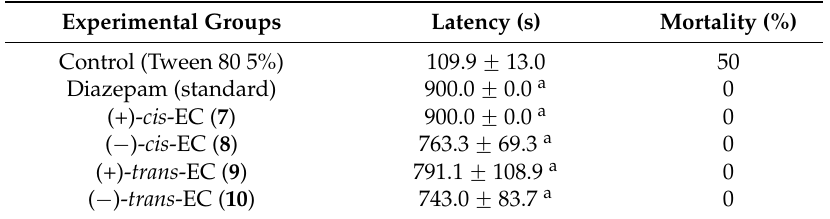
Table 1. Epoxycarvone stereoisomers effect on pentylenetetrazole-induced seizures test. Experimental Groups Latency (s) Mortality (%)